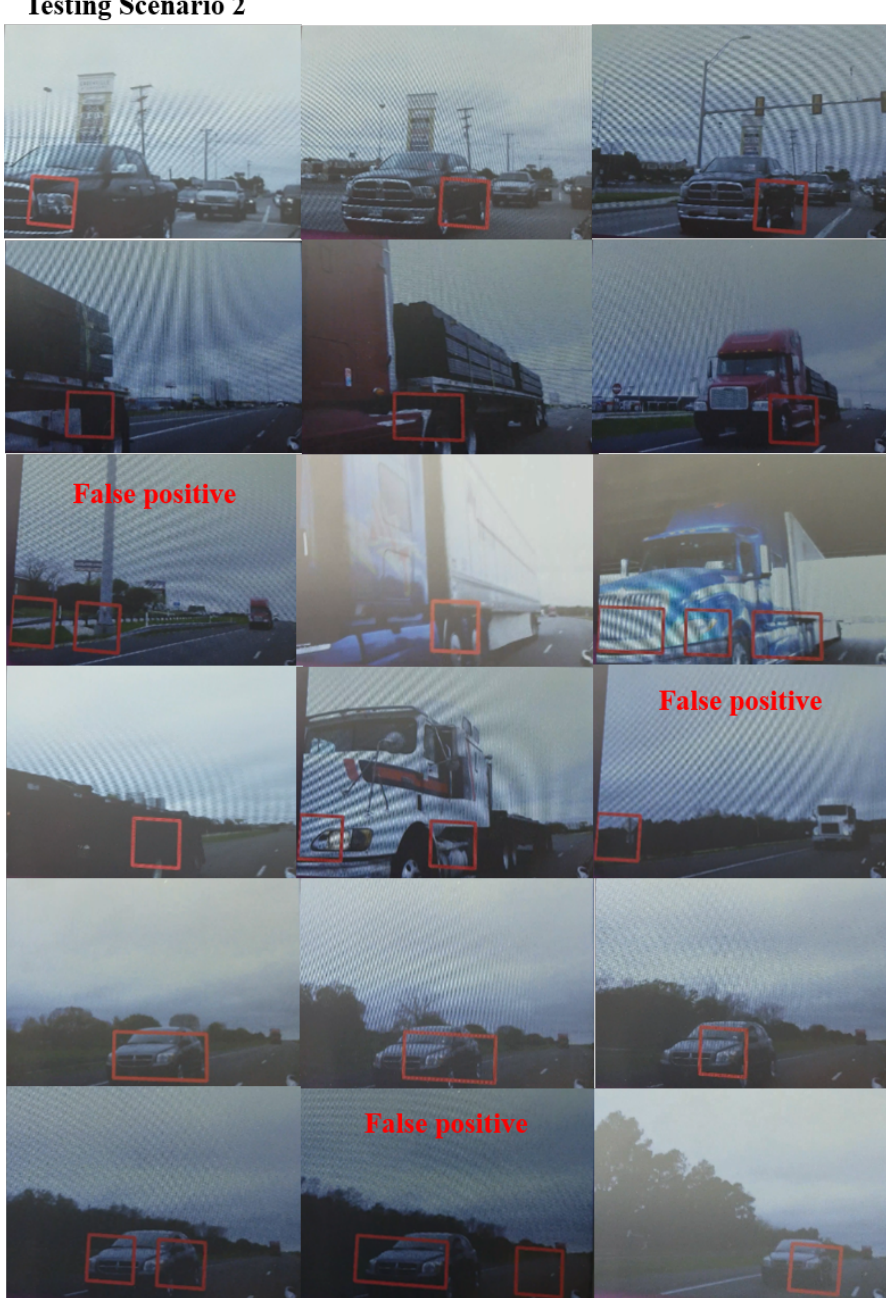
Figure 13. Experimental result of the second testing